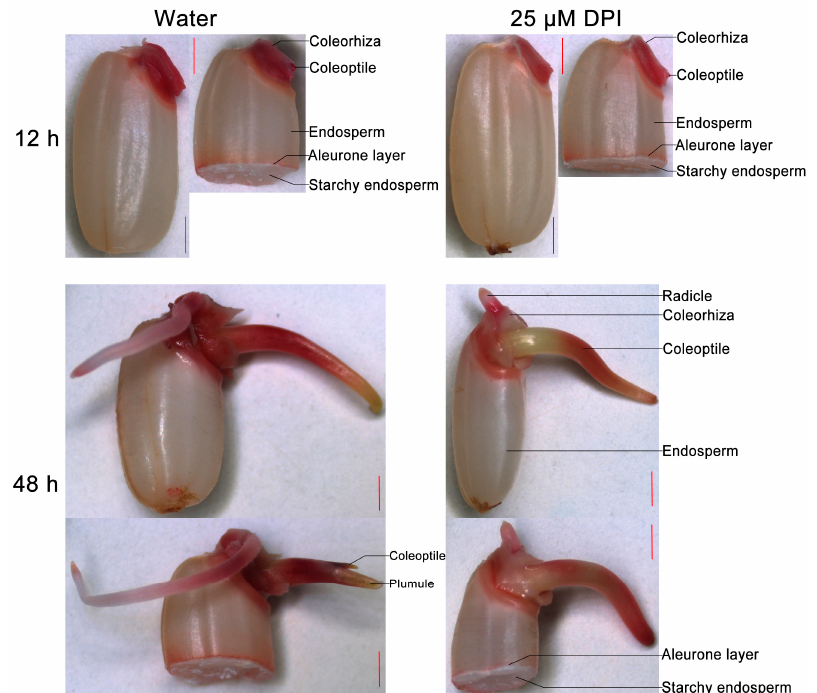
Figure 2. 2,3,5-triphenyltetrazolium chloride (TTC) staining of rice seeds incubated in water or with 25 μ M DPI for 12 or 48 h. After staining, the whole and half granule seeds with embryo were photographed, respectively. Dark-red staining indicates the strong viability of cells or tissues, while light-pink staining indicates the reduced viability of cell or tissue in germinating rice seed. Scale bar, 1000 μ m.